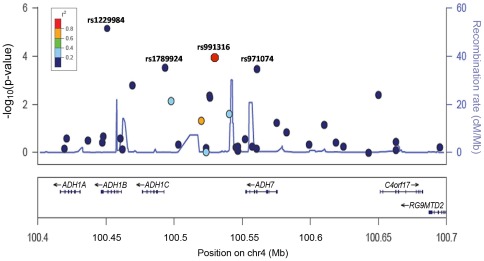
Association results of the SNPs included in the GWAS of oral cancer (by p-values), pair-wise r2 estimates with rs991316, and recombination rates, for SNPs in the ADH gene region on 4q23.P-values indicating the strength of association for each SNP in the GWAS with oral cancer are shown on the −log10 scale (left Y-axis), against their positions on chromosome 4 (Build 36.3). The color of each point and SNP represent the degree of linkage disequilibrium (r2) with rs991316 according to HapMap phase II CEU data. Highlighted in the figure are rs1229984, rs1789924 and rs971074, which have been reported to be associated with UADT cancers previously, as well as the rs991316 SNP which was discovered to be associated specifically with oral cancer in the current study. rs1229984 was not genotyped, nor tagged by a proxy variant on the HumanHap300 BeadChip but was genotyped by Taqman assay in the same samples from Central Europe and ARCAGE studies as included in the discovery phase of current GWAS, and r2 between rs1229984 and rs991316 was estimated in the 3,513 controls from Central European and ARCAGE studies. Recombination rates across the region are shown by the light blue line plotted against the right y axis. Genes in the region are represented with arrow heads indicating the direction of transcription.